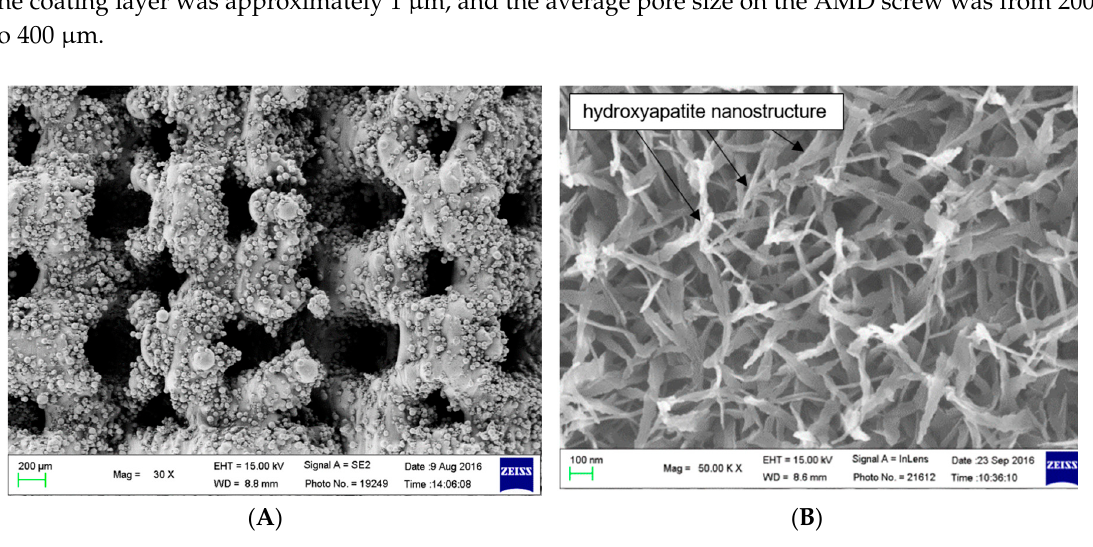
Figure 1. ( A ) Outer surface of the additive manufactured screw. Scanning electron microscopy